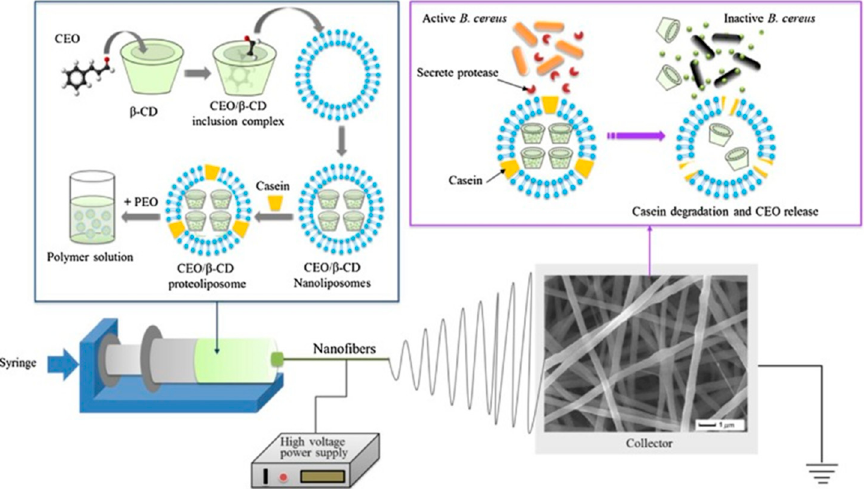
Figure 2. Electrospinning for CEO/ β -CD proteoliposomes incorporated into PEO nanofibers. And schematic of B. cereus proteinase-triggered CEO release from CEO/ β -CD proteoliposomes [49].